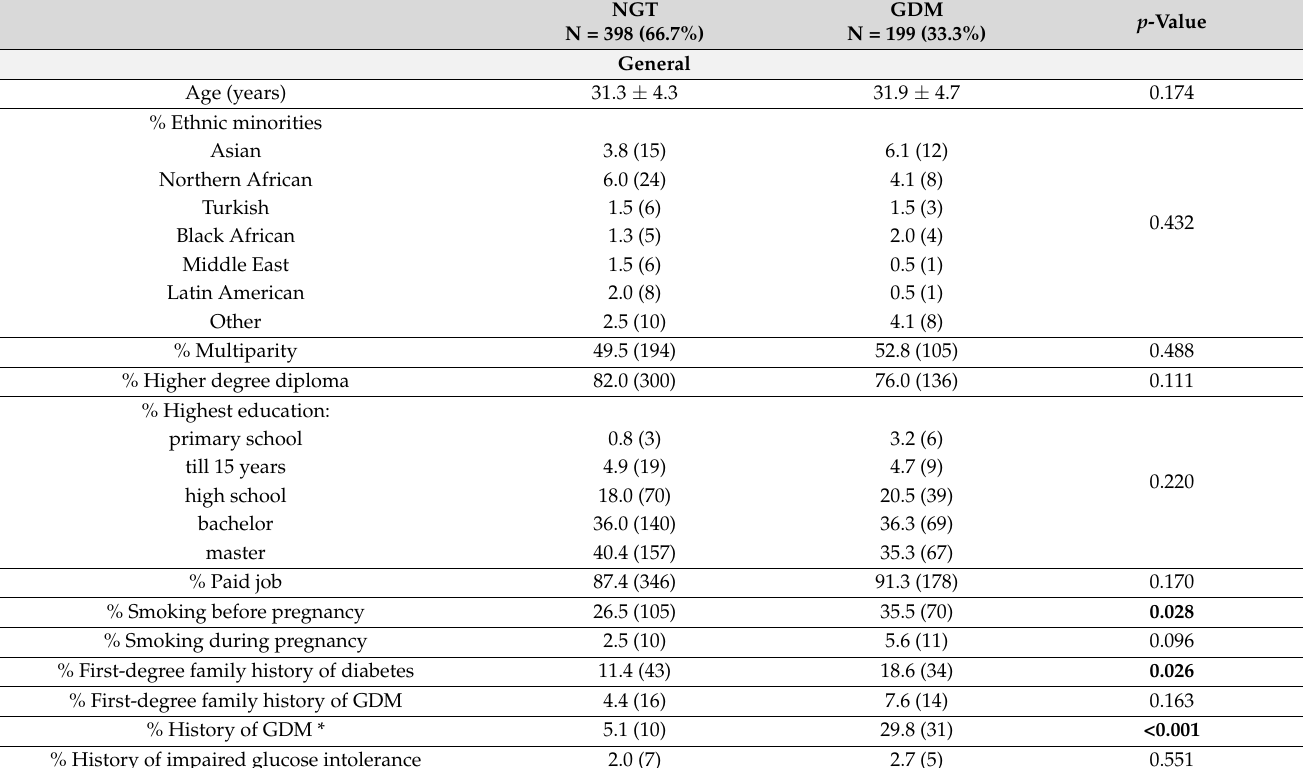
Table A1. Distribution of patient characteristics among women who had GDM and their matched